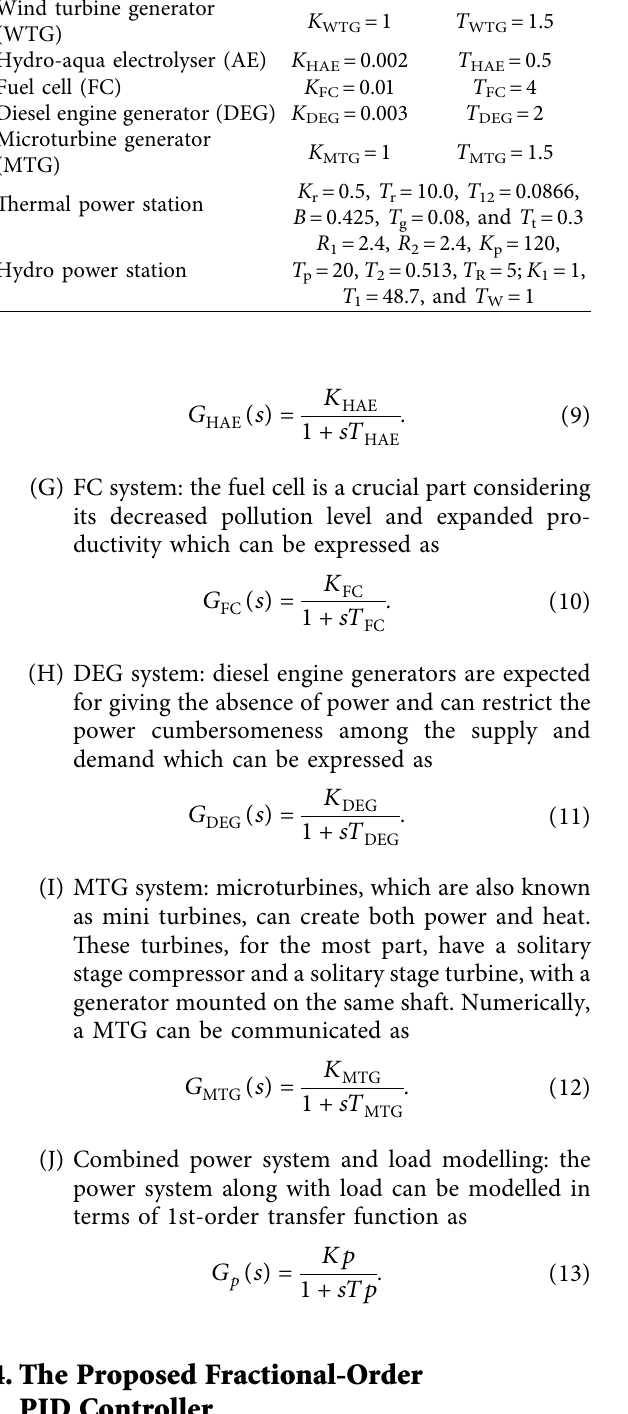
Table 2: Hybrid power system model nominal parameters. Components Gain (K) Time constant (T) Wind turbine